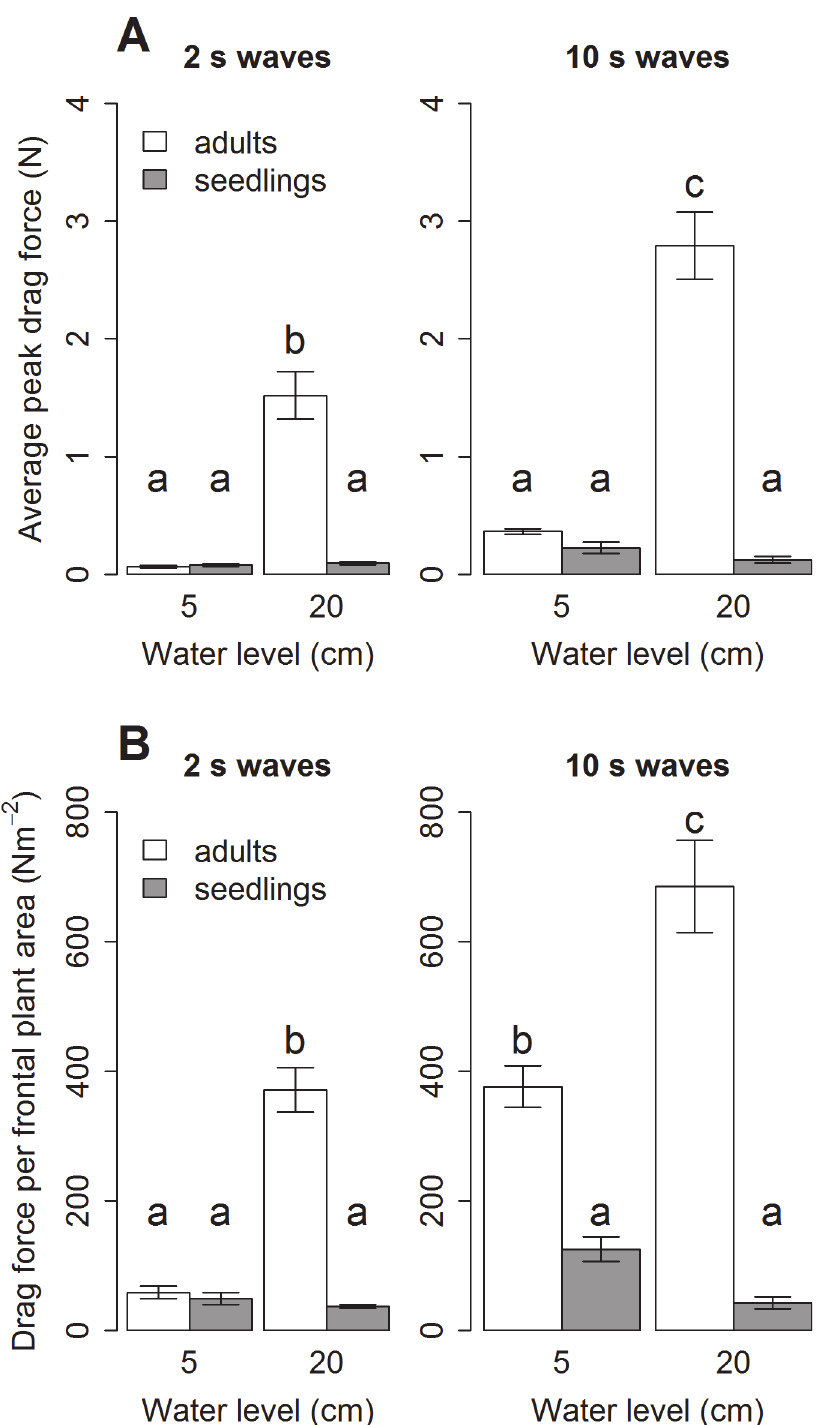
Fig 5. Averages and SE of measured drag forces experienced by plants. A: Average peak drag forces (N); B: Drag forces per frontal plant surface area (Nm − 2 ). Significant differences as resulting from a three-way ANOVA followed by a post-hoc Tukey ’ s HSD are indicated by different